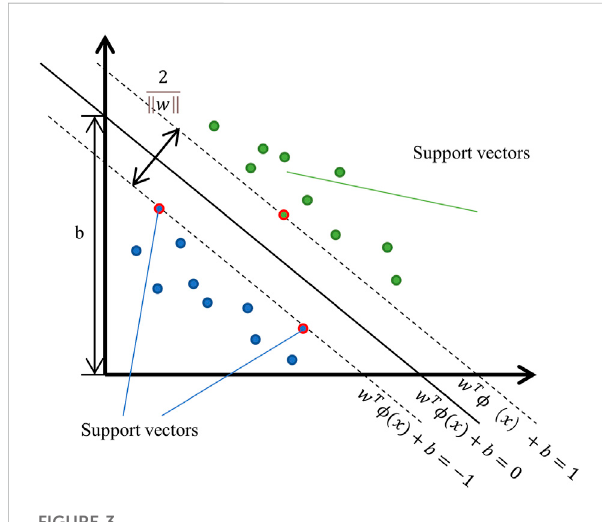
Diagram of a support vector machine